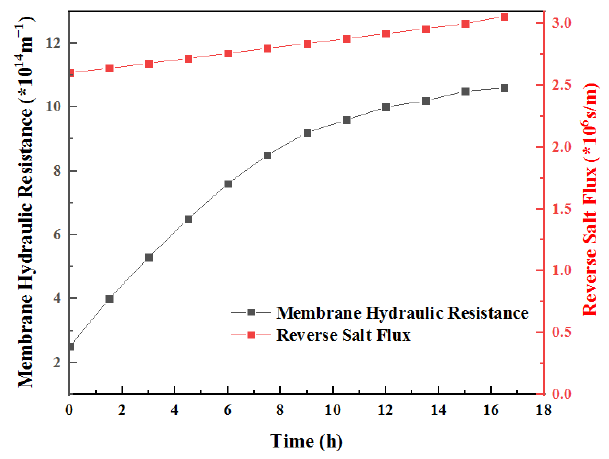
Figure 9. Changes in hydraulic resistance and reverse salt resistance of FO membrane during membrane fouling.